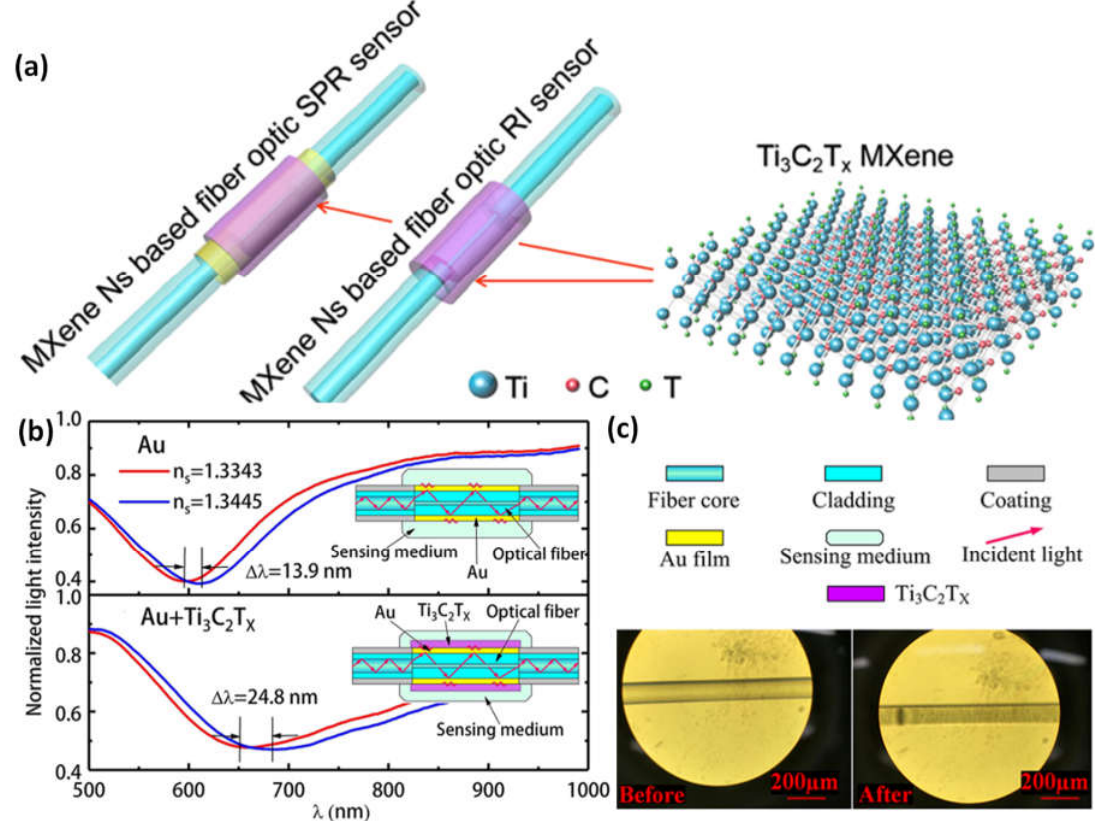
Figure 10. ( a ) 2D MXene Ti 3 C 2 T x improves the sensitivity of optical fiber nanosensors, including